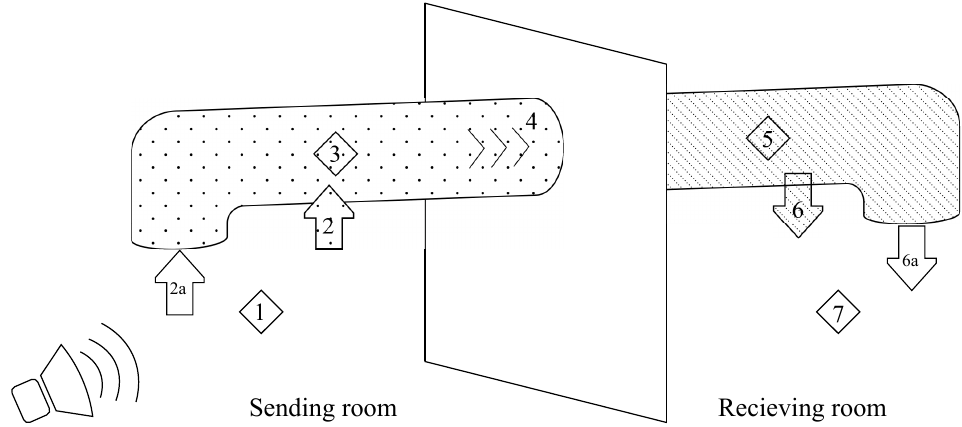
Figure 2. Illustration model of how sound travels from the sending room to the receiving room if the surface area and air diffusers affects the sound transmission.